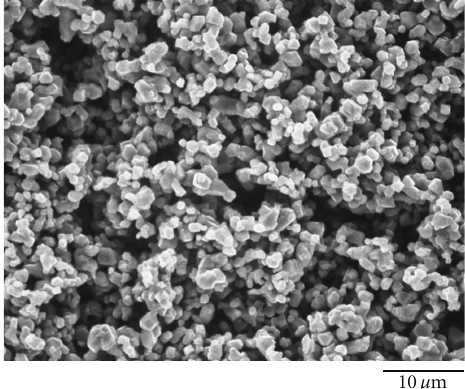
Figure 3: SEM photograph of LiNi 0 . 5 Mn 1 . 5 O 4 powders calcined at 800 ◦ C.